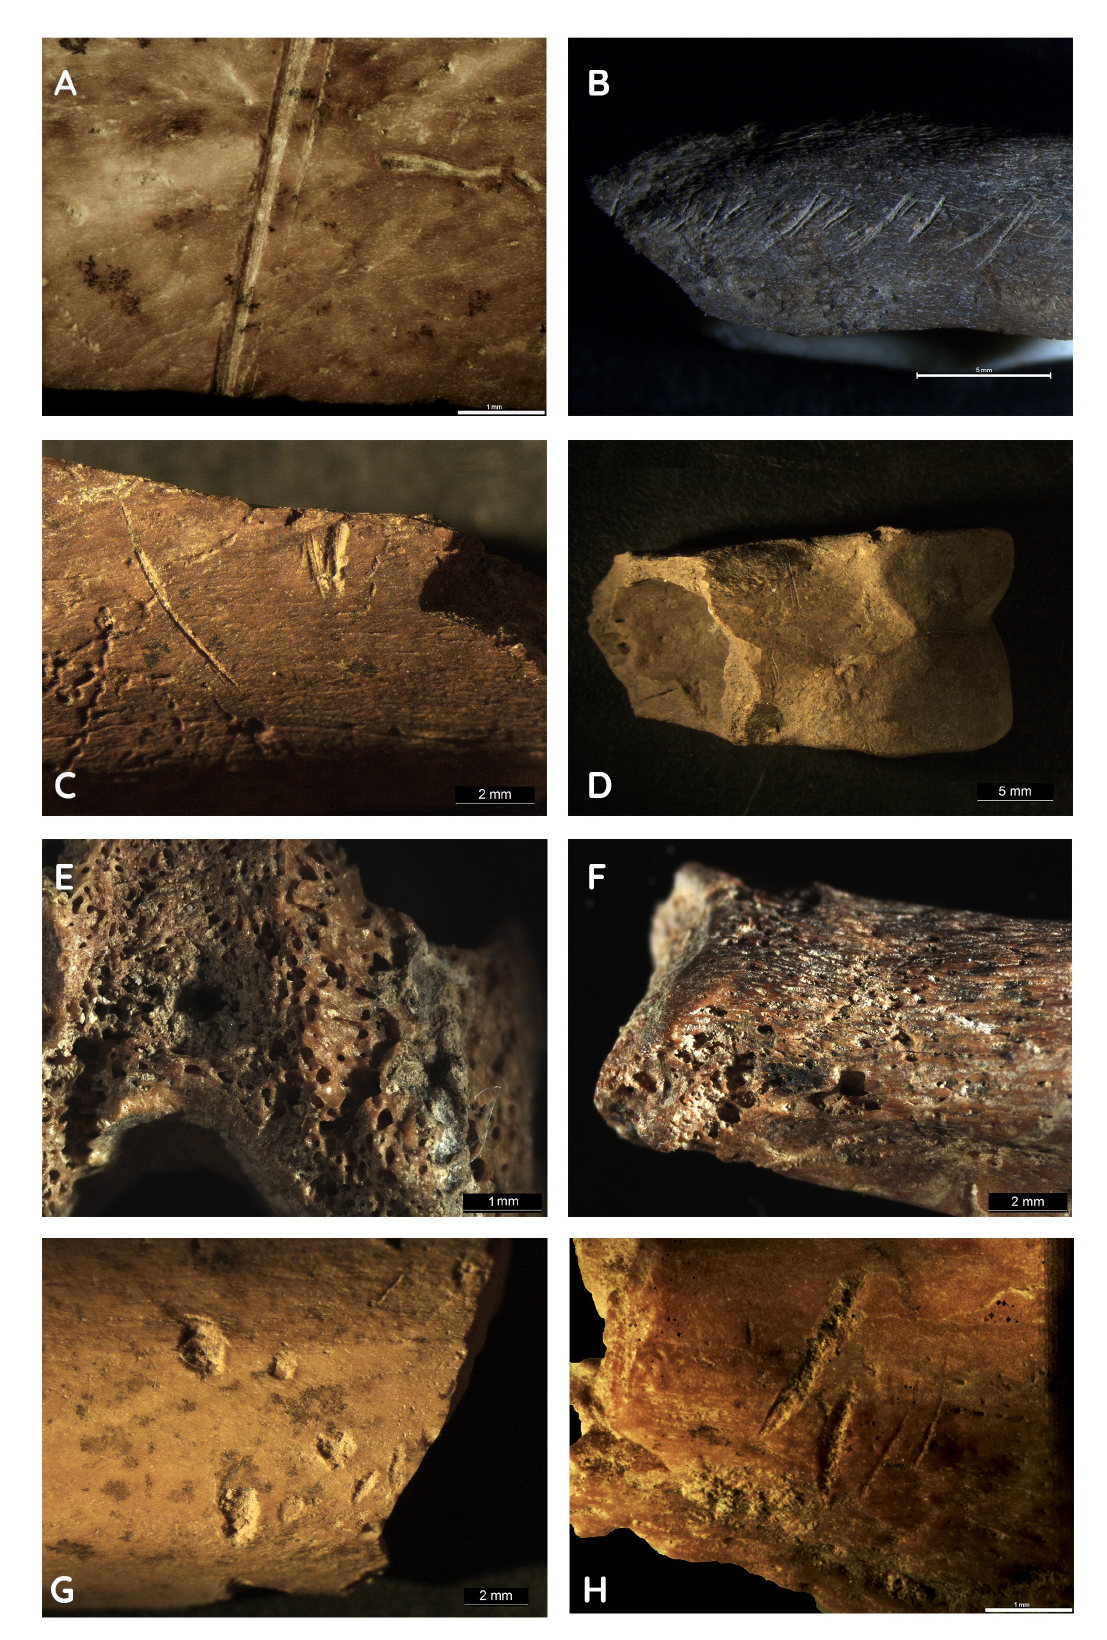
Figure 3. Bioestratinomic damage examples. There are anthropogenic marks: slicing and scraping marks ( A – D ), Predator non-anthropogenic marks: digestion ( E , F ), punctures ( G ), and scores ( H